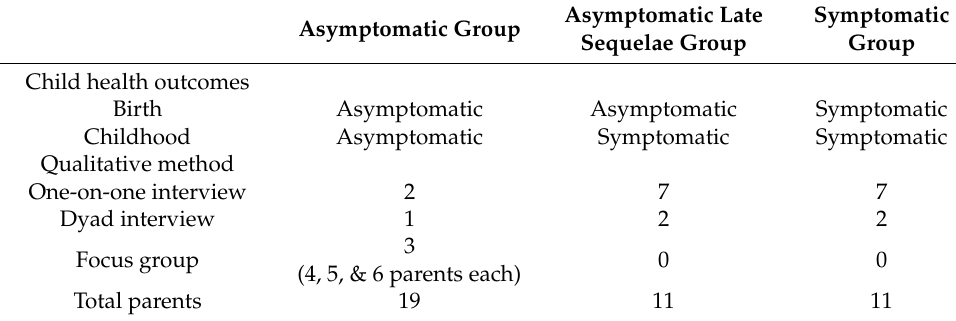
Table 1. Description of parent groups and types of information collection. Child health outcomes